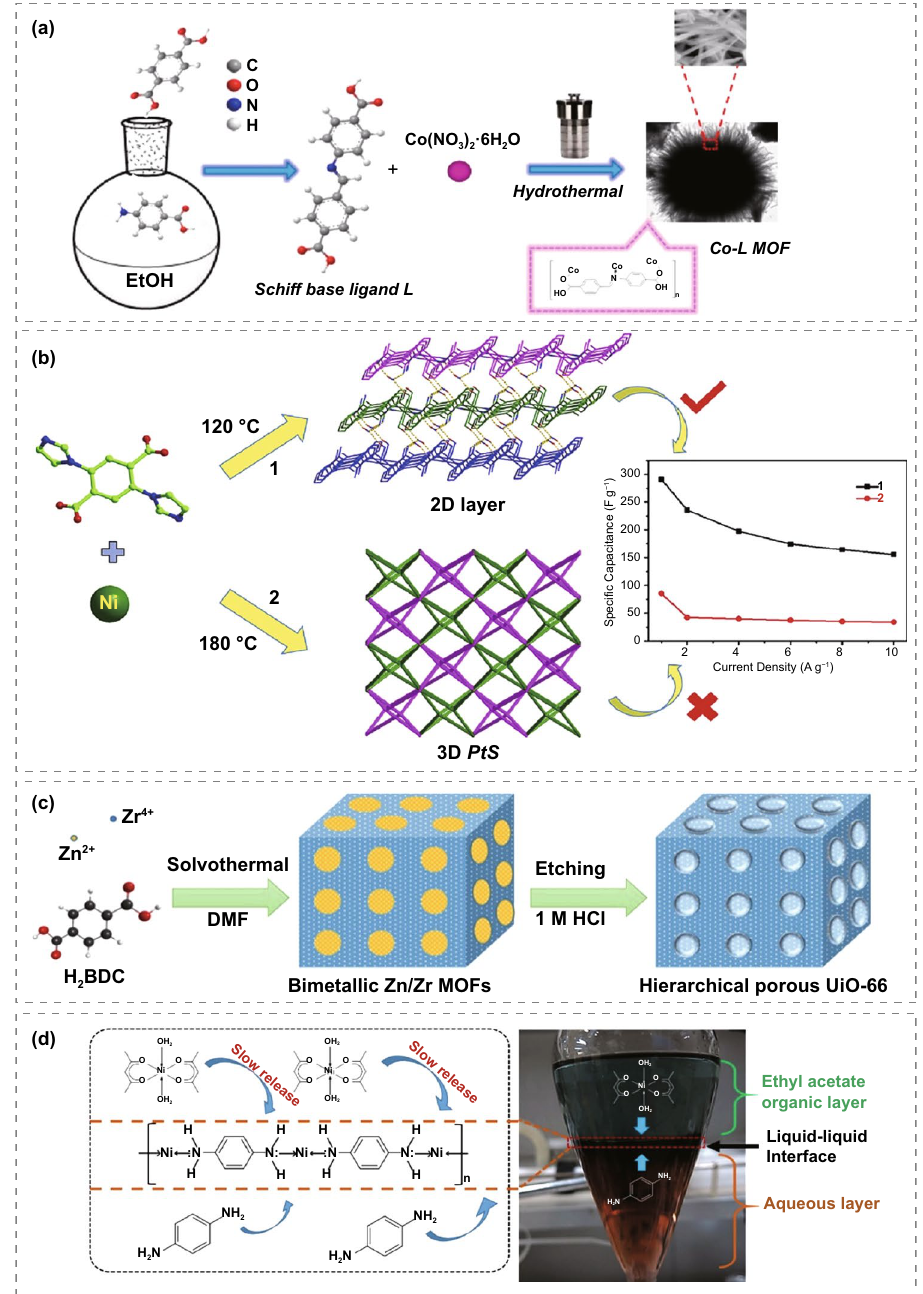
Fig. 5 a The synthesis diagram of Co-L MOF. Reprinted with permission from Ref. [82]. Copyright 2019 Elsevier B.V. b Influence of tempera- ture on synthesis of two Ni-MOFs. Reprinted with permission from Ref. [86]. Copyright 2019 Elsevier Inc. c Schematic diagram of preparation process of HP-UiO-66. Reprinted with permission from Ref. [92].Copyright 2017 American Chemical Society d Schematic diagram of liquid– liquid interface reaction of Ni-pPDA MOF at room temperature. Reprinted with permission from Ref. [94]. Copyright 2018 Elsevier